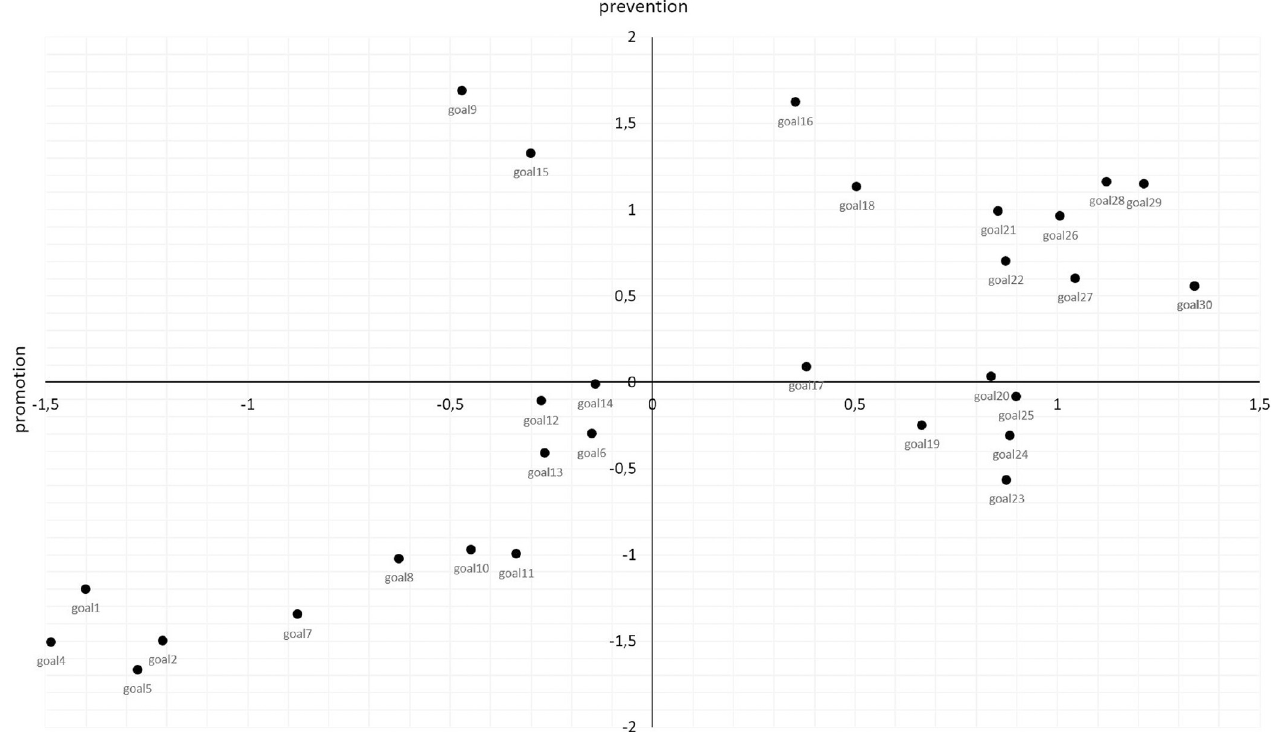
Fig 1. An example of a point map based on multidimensional scaling in Study 1.